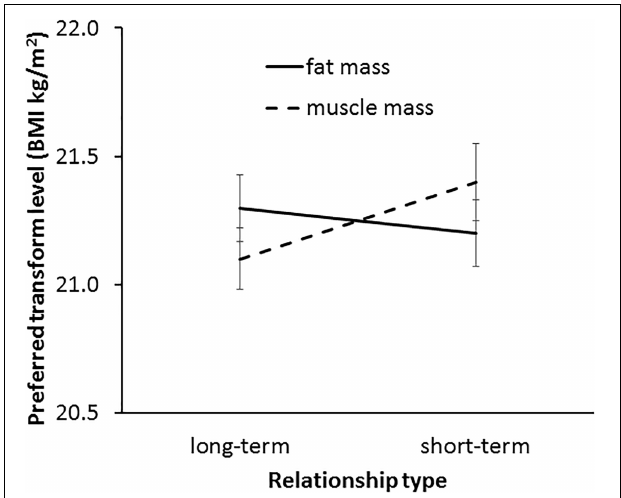
FIGURE 10 | The interaction between relationship context (short-term vs. long-term relationship) and preferred facial correlates of body composition (fat mass and muscle mass) in MTurk participants. The vertical axis represents the associated BMI of the most preferred faces. Error bars represent standard